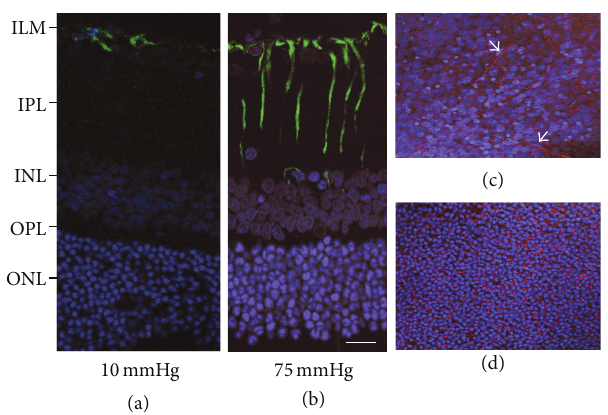
Figure 3: Immunofluorescent localization of glial fibrillary acidic protein by confocal fluorescent microscopy. (a) GFAP expression is recognized as FITC fluorescence, and localized in the M¨uller cells endfeet of (arrow) in a normal retina (10mmHg). (b) Apparent fluorescent reaction is recognized in the M¨uller cell body (arrow- heads) and the M¨uller cells endfeet (arrow) at 75 mmHg. (c) and (d) Tangential view of the GFAP expression at the level of the inner nuclear layer (c) and the outer nuclear layer (d). GFAP- stained M¨uller cell bodies were recognized as (rhodamine-stained) reddish dots among the DAPI- (4 󸀠 ,6-diamidino-2-phenylindole dihydrochloride) stained nuclei. Note the obliquely running M¨uller cell process (arrows). Figures (a) to (d) are in the same magnifica- tion. Figures (a) to (d) are in the same magnification. Bar = 20 𝜇